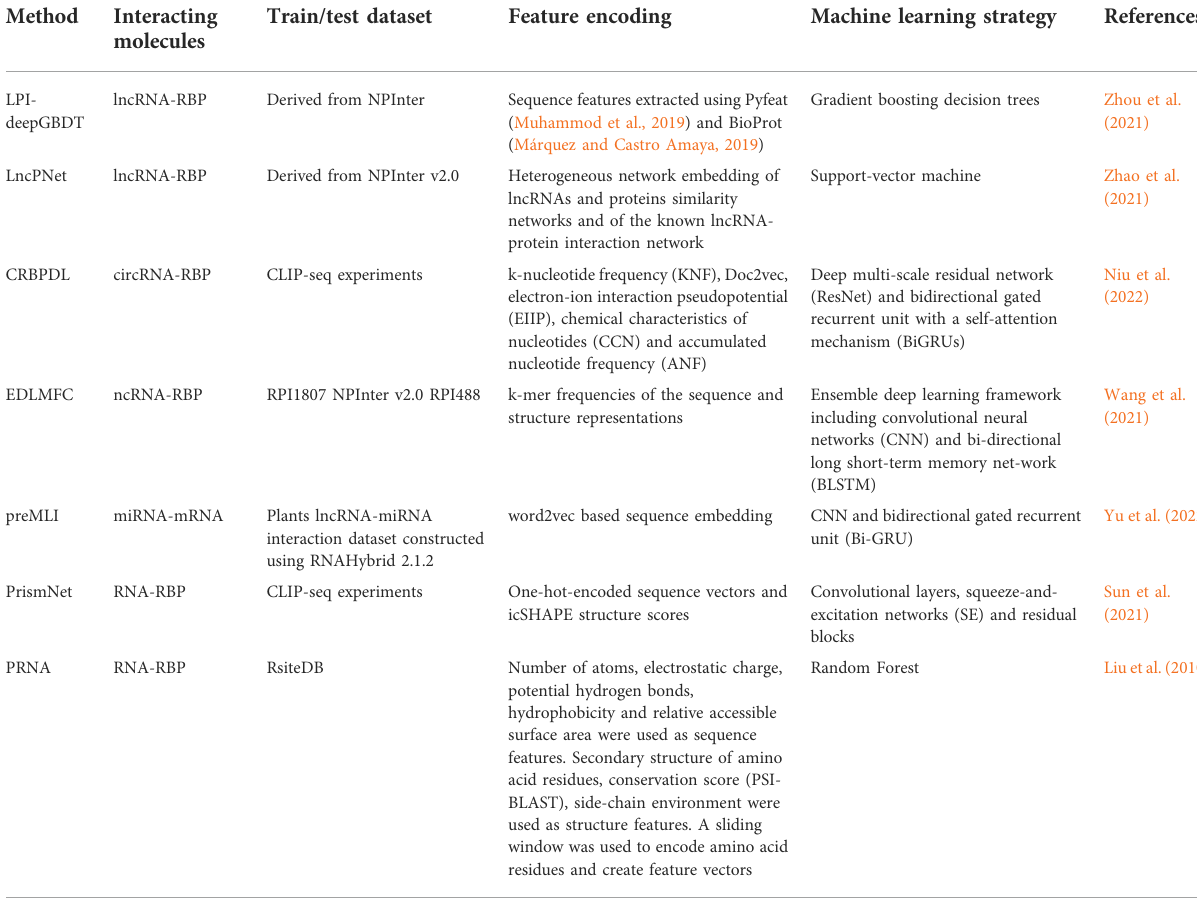
TABLE 6 Description of the train/test datasets, feature encoding and machine learning strategy for each of the described